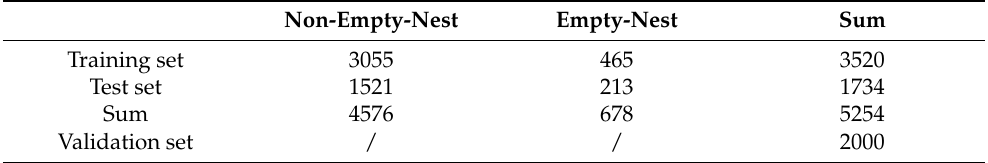
Table 1. User data of training set and test